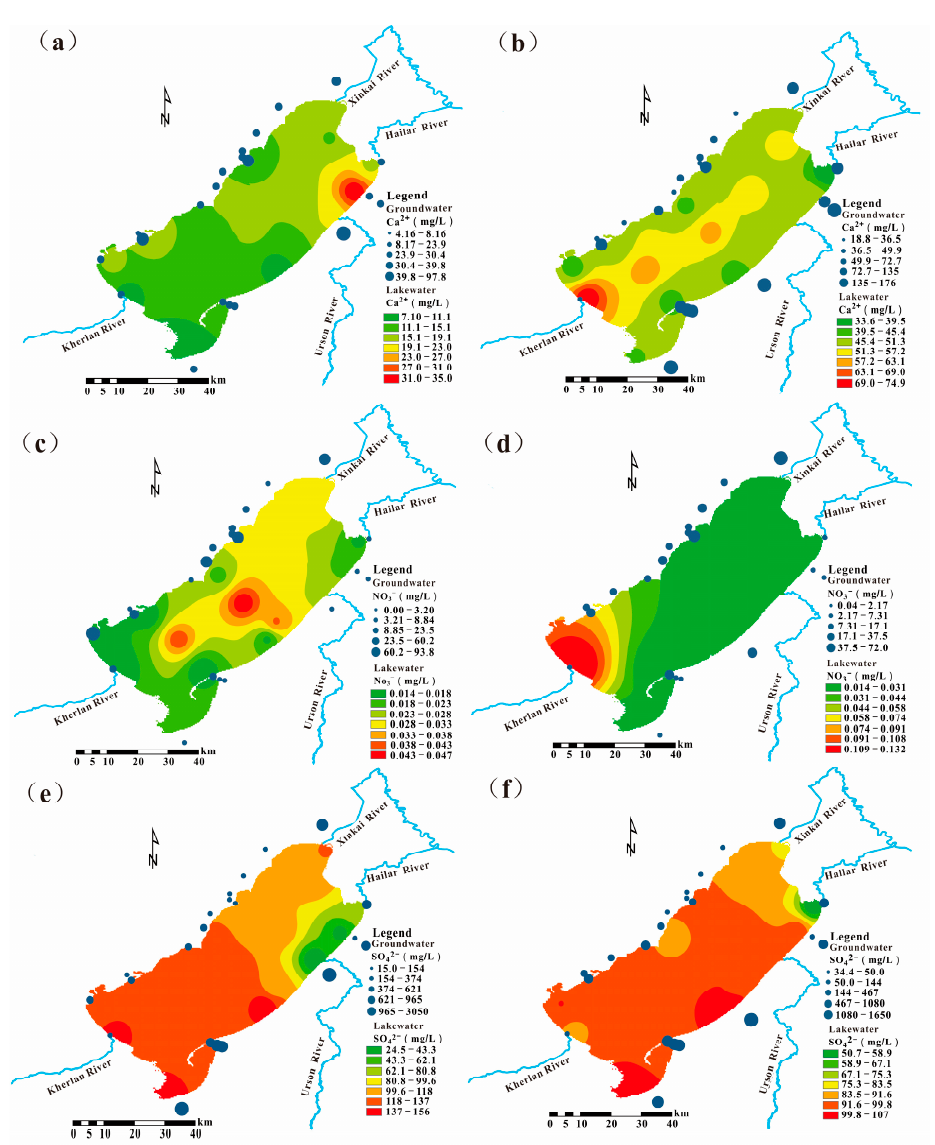
Figure 7. Spatial interpolation map of the main hydrochemical ions in the Hulun Lake Basin: ( a ) Ca 2+ concentration during the frozen season; ( b ) Ca 2+ concentration during the non-frozen season; ( c ) NO 3 − concentration during the frozen season; ( d ) NO 3 − concentration during the non-frozen season; ( e ) SO 42 − concentration during the frozen season; ( f ) season SO 42 − concentration during the non-frozen.